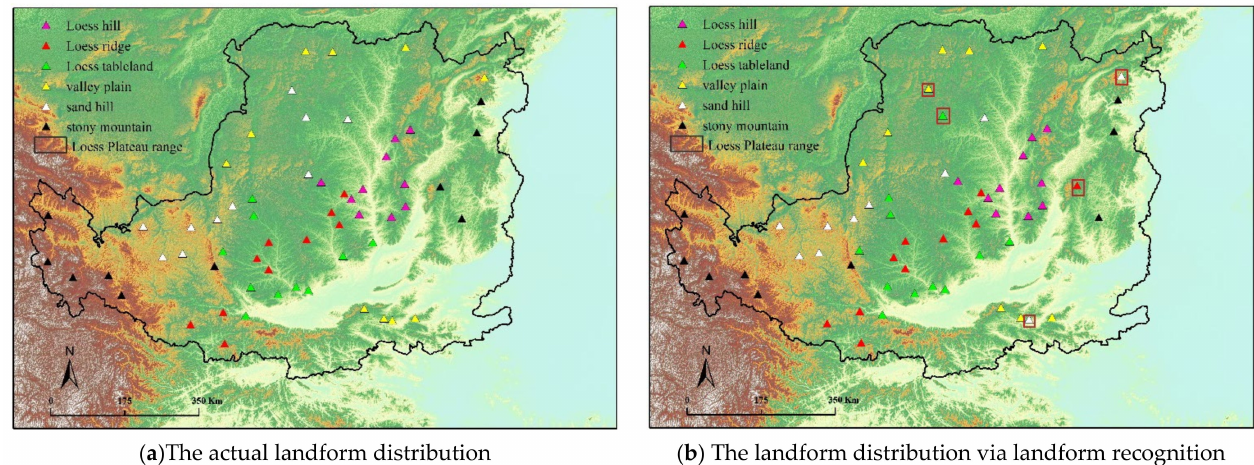
Figure 12. The comparison of the actual landform types ( a ) and the recognition results via the combination of P–N terrain spatial structure and the WWCN spatial structure ( b ).